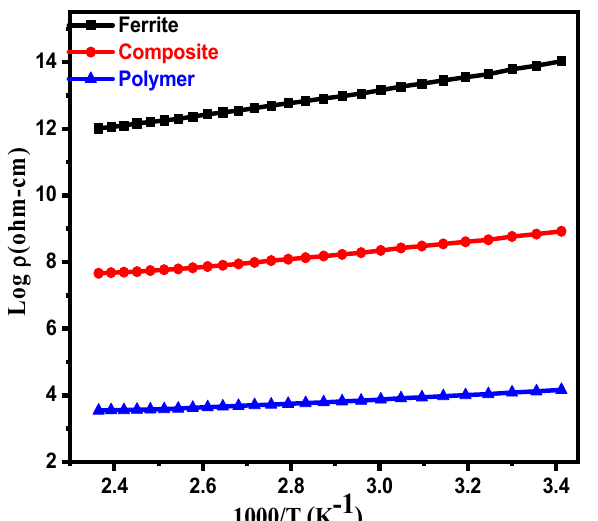
Figure 1. Temperature-dependent resistivity for y-type hexaferrite Sr 2 Co 2 Fe 12 O 22 ,composite (Sr 2 Co 2 Fe 12 O 22 + PPy-DBSA) and polymer (PPy-DBSA).